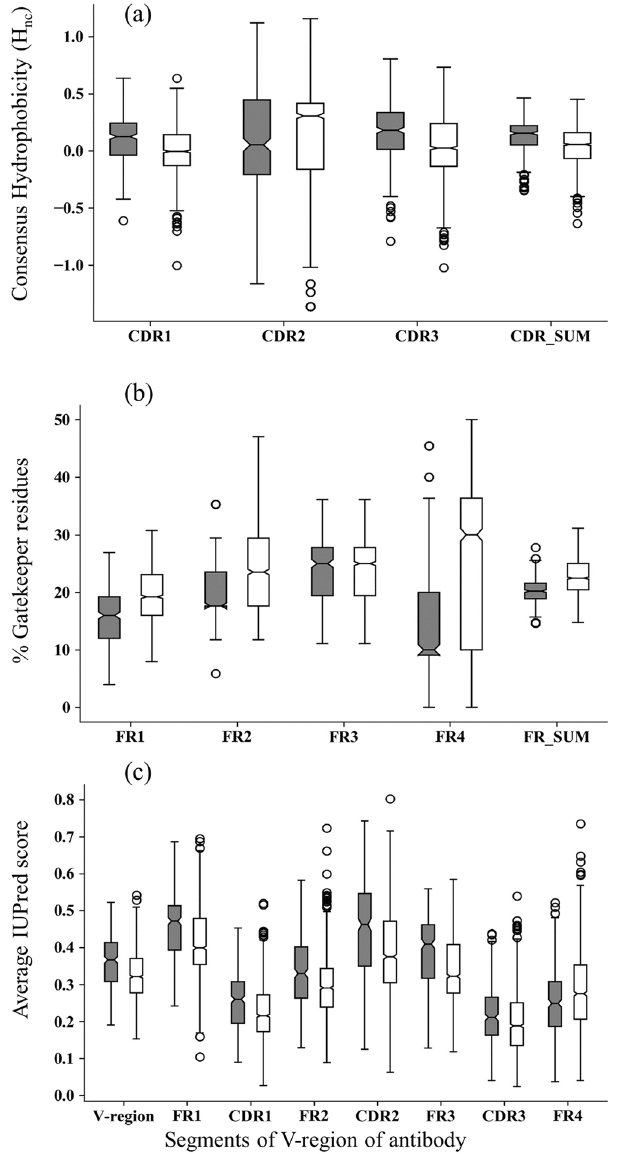
of V L -region of amyloidogenic (grey) and non-amyloidogenic (white)